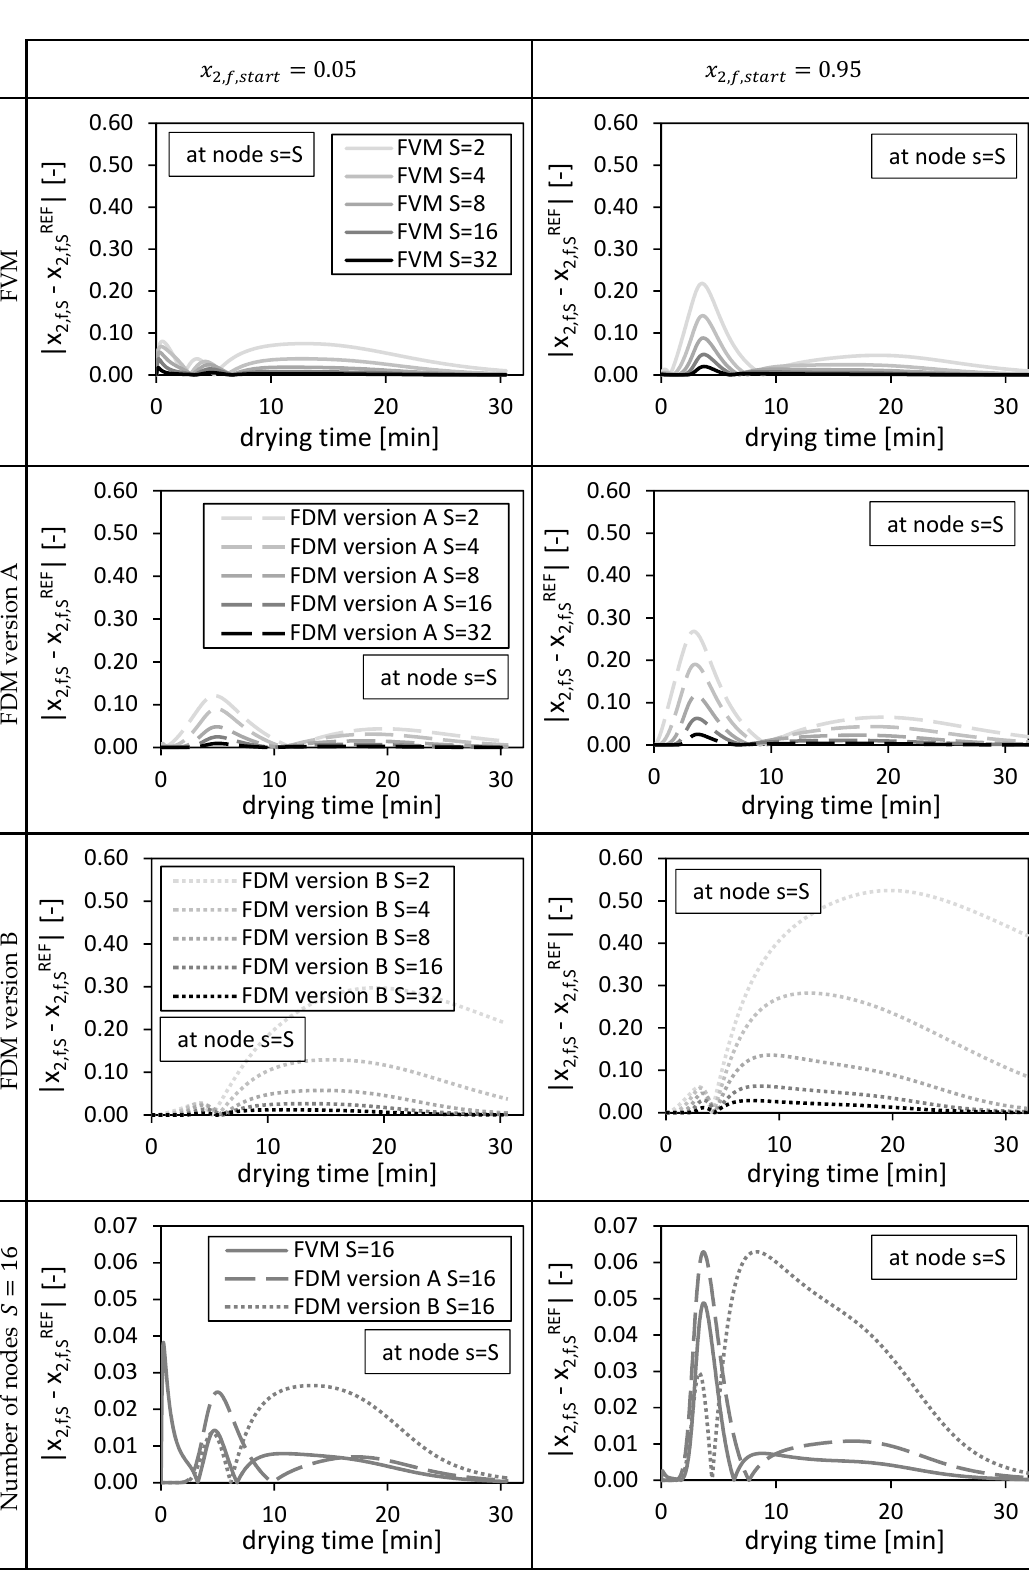
Figure 4. Absolute deviation from reference solution at final node s = S for the FVM, FDM version A and B, using x (cid:2870),(cid:2916)(cid:2929)(cid:2930)(cid:2911)(cid:2928)(cid:2930) = 0.05 (left panels) and x (cid:2870),(cid:2916)(cid:2929)(cid:2930)(cid:2911)(cid:2928)(cid:2930) = 0.95 (right panels), depending on the drying time and the number of nodes S. Calculation settings: N = 26, S REF = 64, Δ t = 0.05 s (for FVM, FDM version A and B).